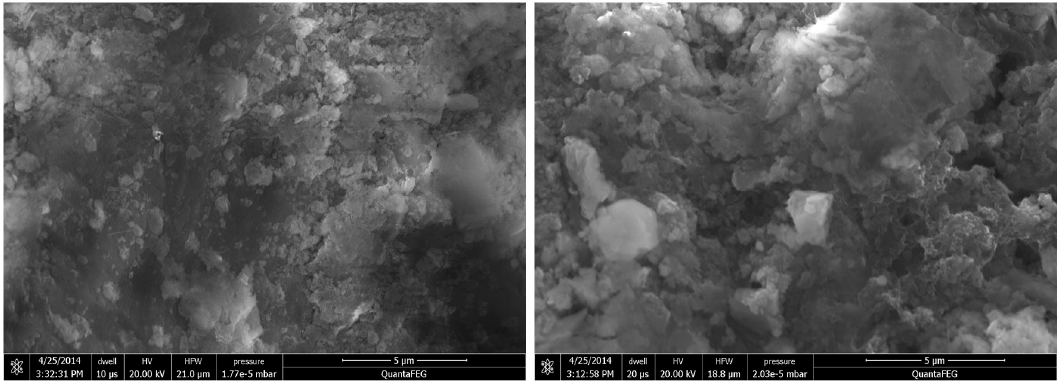
Figure 4. SEM images of raw ( left ) and activated ( right ) hydrochar.